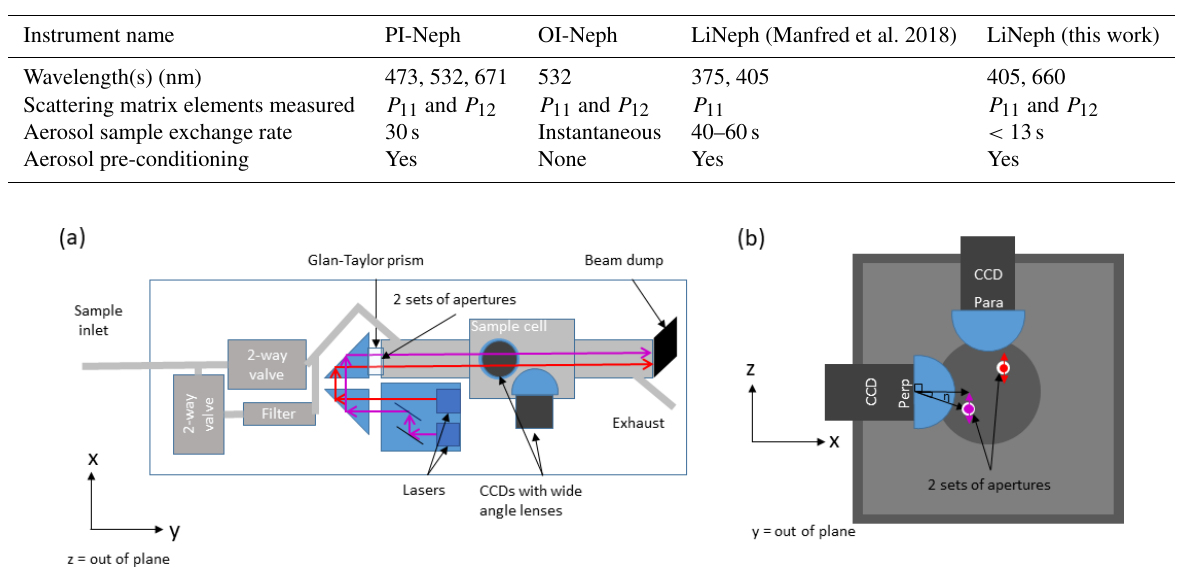
Table 1. Comparison of some existing imaging nephelometers.